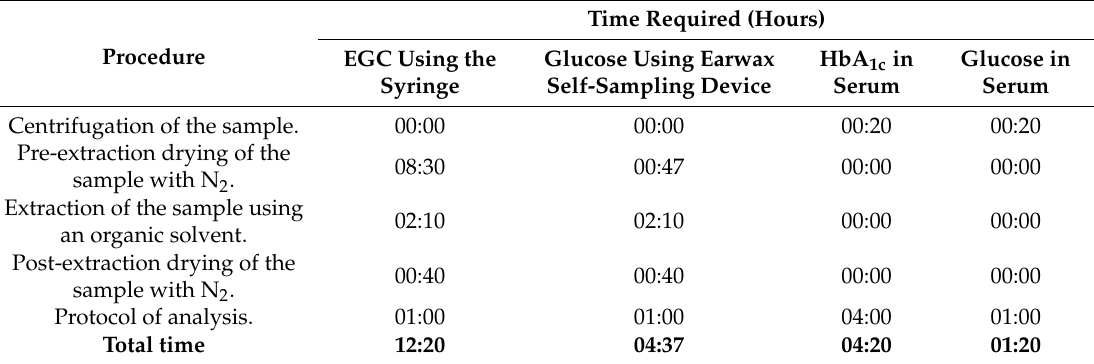
Table 5. Time required to analyse di ff erent